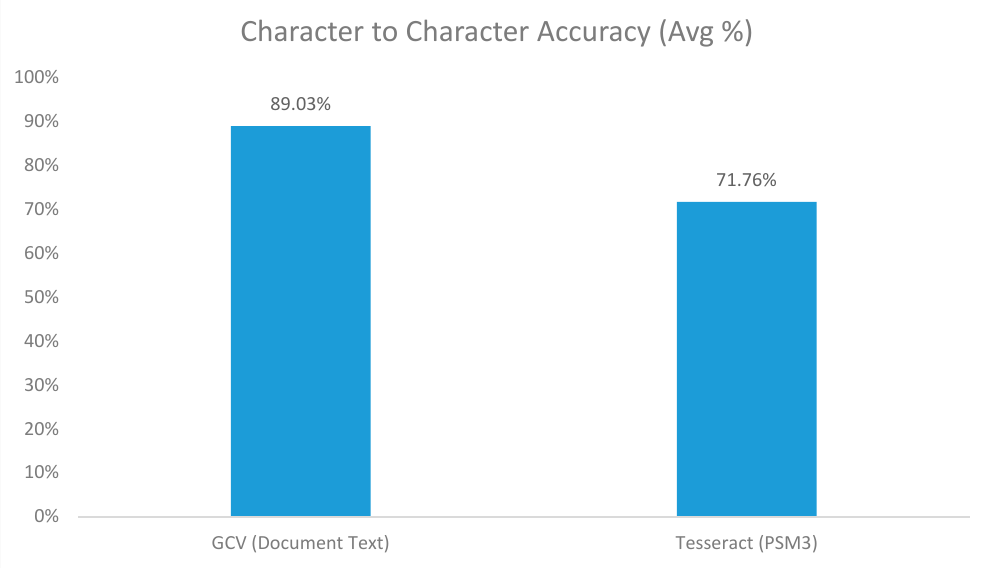
Figure 2. Average accuracy calculation—raw image digitalization across each platform (Google Cloud Vision versus Tesseract).